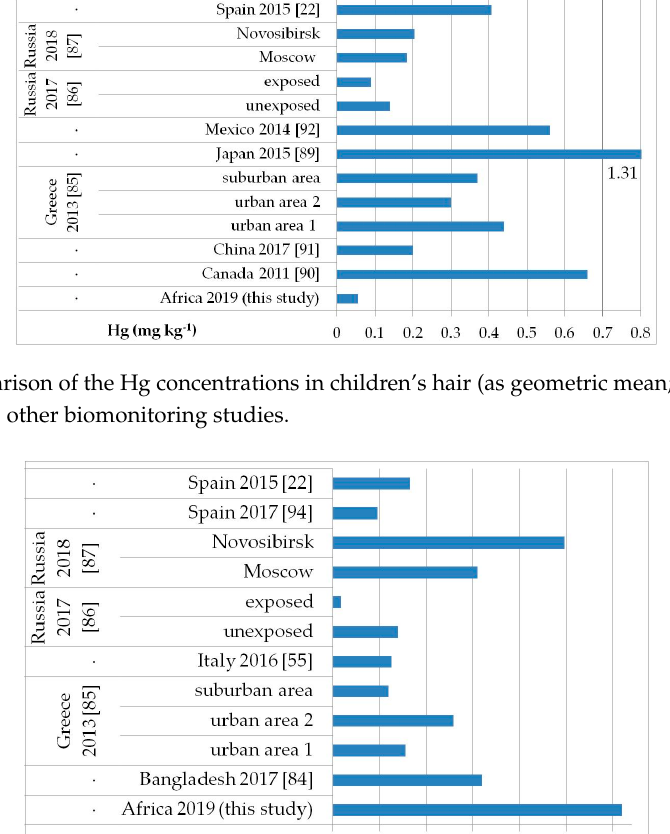
Figure 5. Comparison of the Pb concentrations in children’s hair (as geometric mean; mg kg − 1 ) found in our study and other biomonitoring studies.